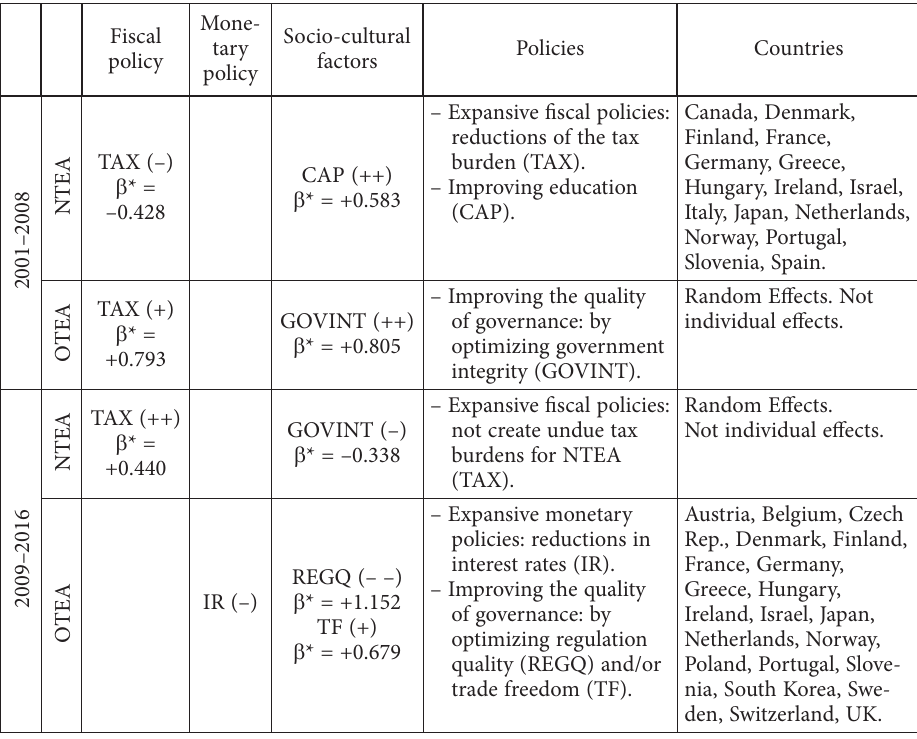
Table 7. Summary of results obtained: determinant factors and standardized